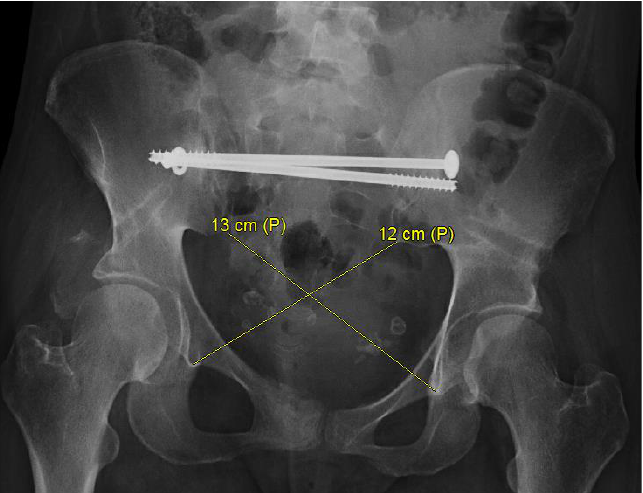
Figure 3. Anteroposterior radiograph of a pelvic malunion with internal rotation deformity of the right hemipelvis demonstrating diagonal distance from the low border of the sacroiliac joint to the bottom of the radiographic tear drop in skeletally mature patients.